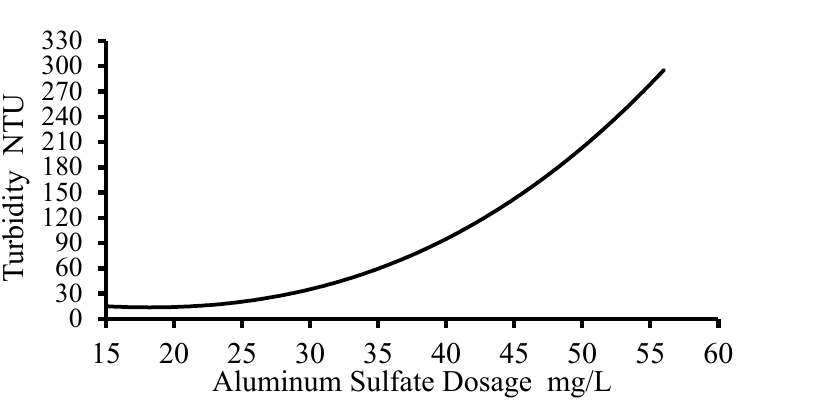
Figure 5. Coagulant dosage curve.